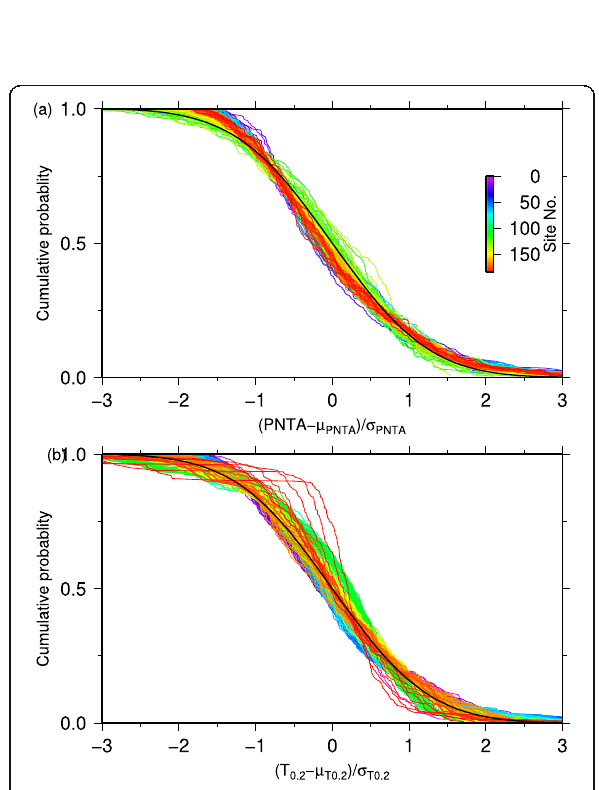
Fig. 6 Cumulative distributions of the probabilities of exceedance. a PNTA. b Arrival time at each observation site. Each curve is centered at the average ( μ ) and normalized by the standard deviation ( σ ) at each site. The black line is the error